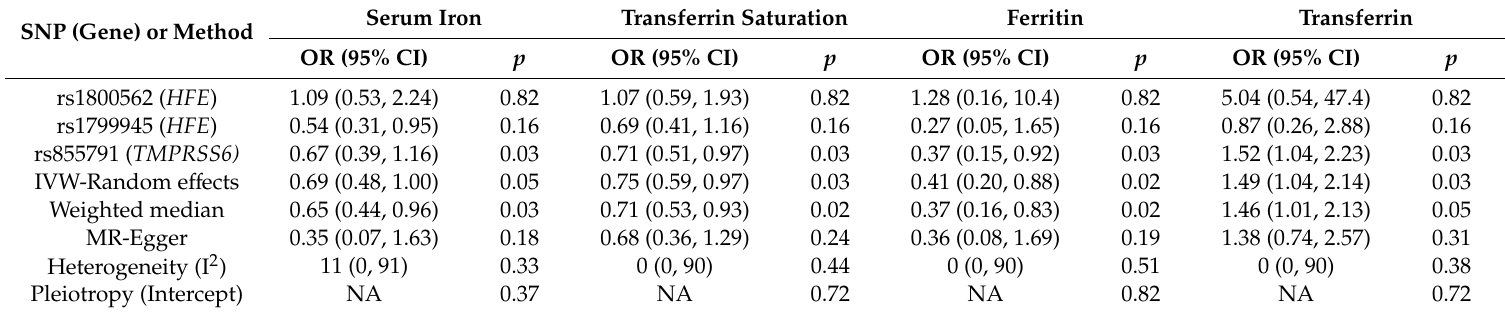
Table 4. Associations between genetically predicted iron status, based on 3 primary SNPs, and brain cancer in sensitivity analyses. Serum SNP (Gene) or Method